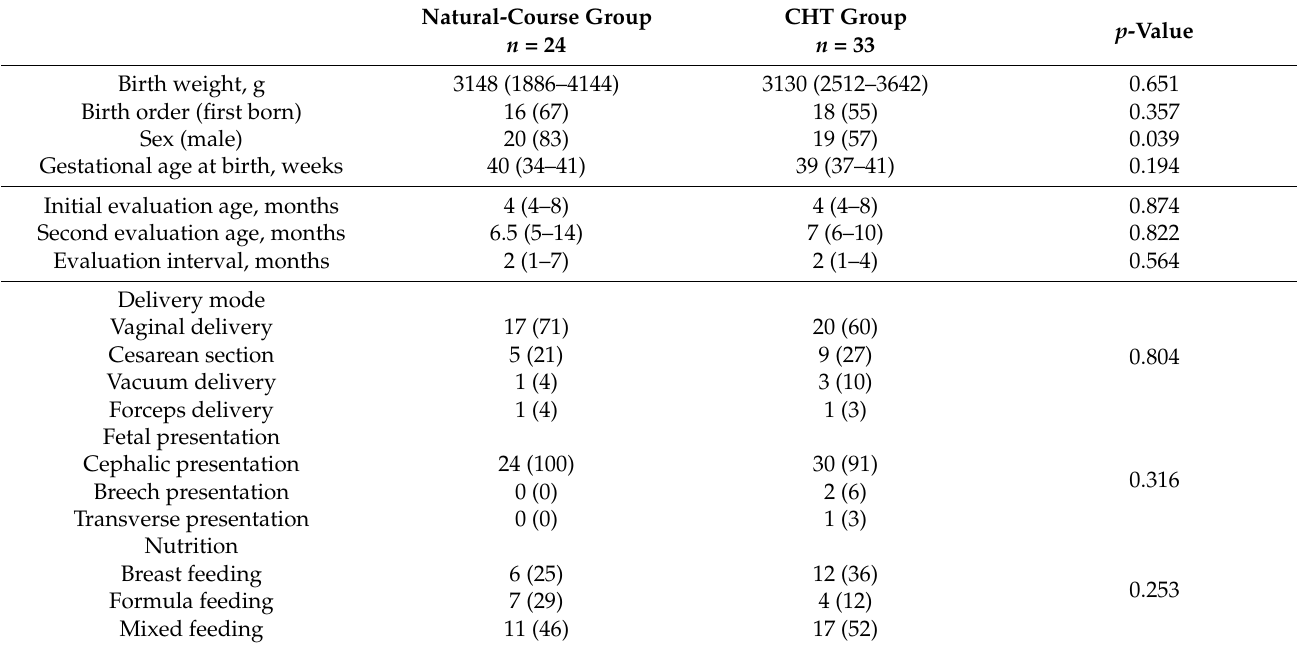
Table 2. Comparisons of obstetric factors and evaluation age between the natural-course and cranial helmet therapy groups.